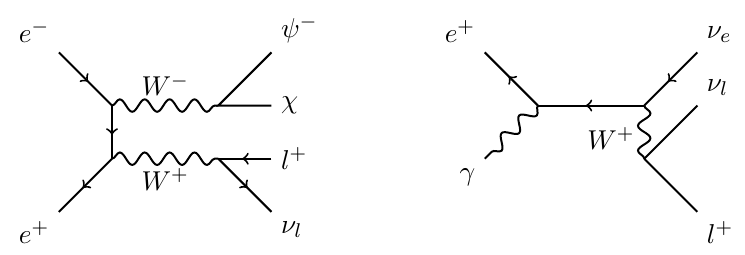
Figure 14 . Illustrative processes for potential mono-lepton searches. (Left): signal process e + e (cid:0) ! + (cid:31)l (cid:0) (cid:23) l for lepton l . (Right): beamsstrahlung-initiated irreducible background relevant for all